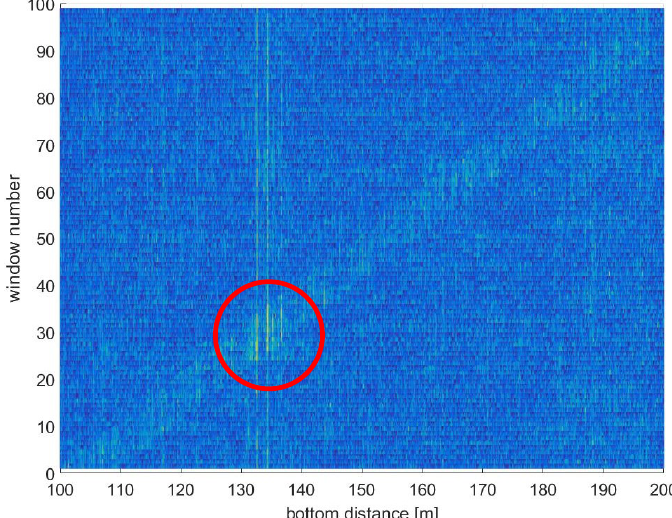
Figure 4. 2D plot obtained by matched filtering the received signals after radiating time reversed signals while changing a transmission waveform section. The target peak is marked with the red circle.